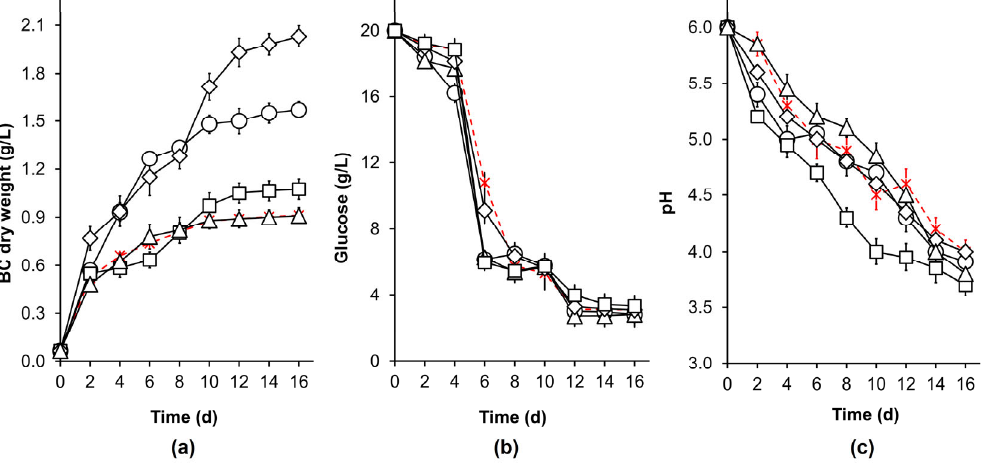
Figure 1. Kinetic of ( a ) BC production, ( b ) glucose consumption and ( c ) pH changes in K. xylinus static culture (HS medium). Effect of: UV light, 366 nm ( ); Static magnetic field, 1T magnet ( ); NaCl, 5 g/L ( □ ); and chloramphenicol, 0.25 mM ( ). BC production in the same medium without stimuli (control) is depicted with the dotted line in red color (x).